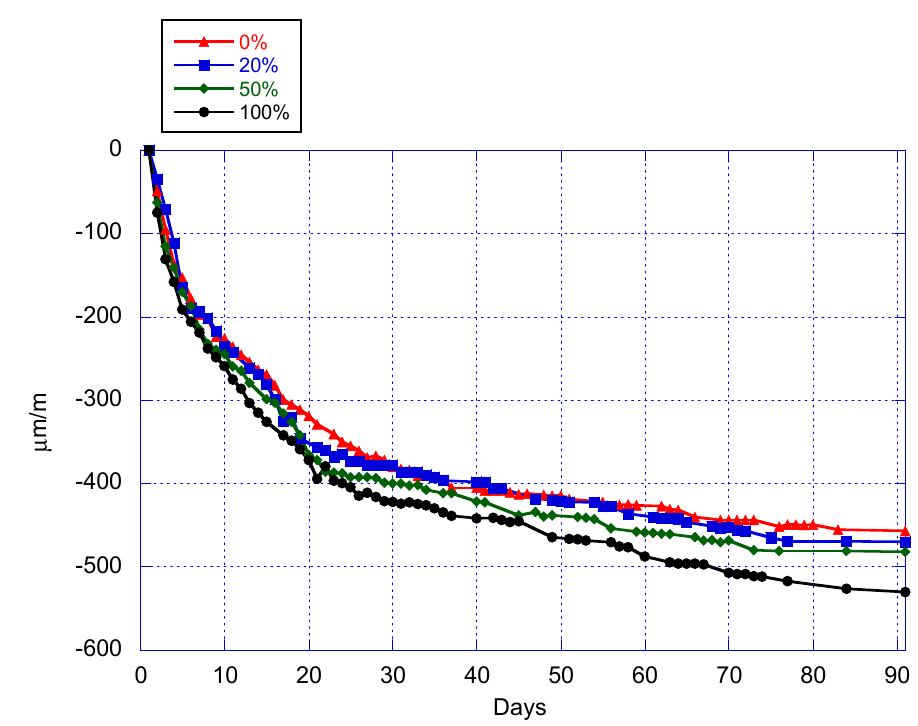
Figure 11. Mean drying shrinkage over time for all mixes.